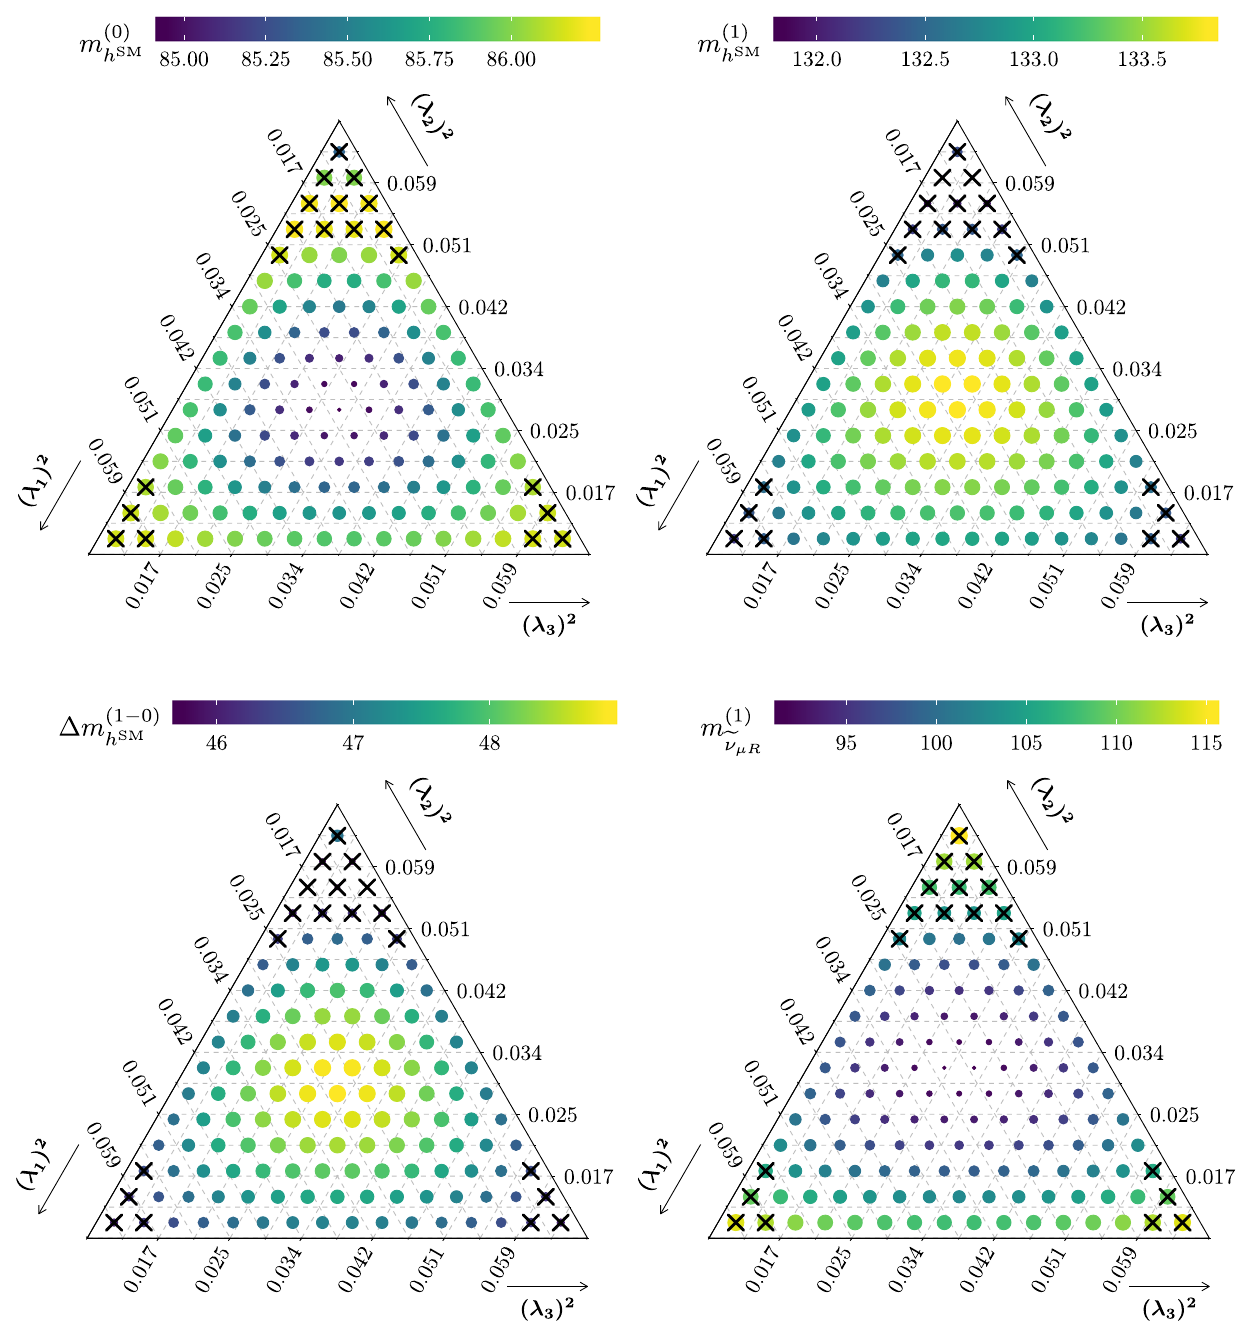
= m Fig. 8 SM-like Higgs-boson mass at tree level m ( 0 ) ( top (and sizes for better visibility). Crossed points are excluded by either h ( 0 ) 1 h SM HiggsBounds , HiggsSignals with χ 2 = m left ), and at one-loop level m ( 1 ) ( top right ), and their differ- the 13 TeV data set, or because the SM-like Higgs boson mass includ- h ( 1 ) 2 h SM ( 1 − 0 ) = m ( 1 ) − m ( 0 ) ing the two-loop corrections is smaller than 123 GeV or larger than 127 ence (cid:15) m ( bottom left ), and the one-loop mass of h SM h SM h SM GeV λλλ 2 but varying λ (cid:4) ν μ R ( bottom right ) for fixed i , indicated by the colors